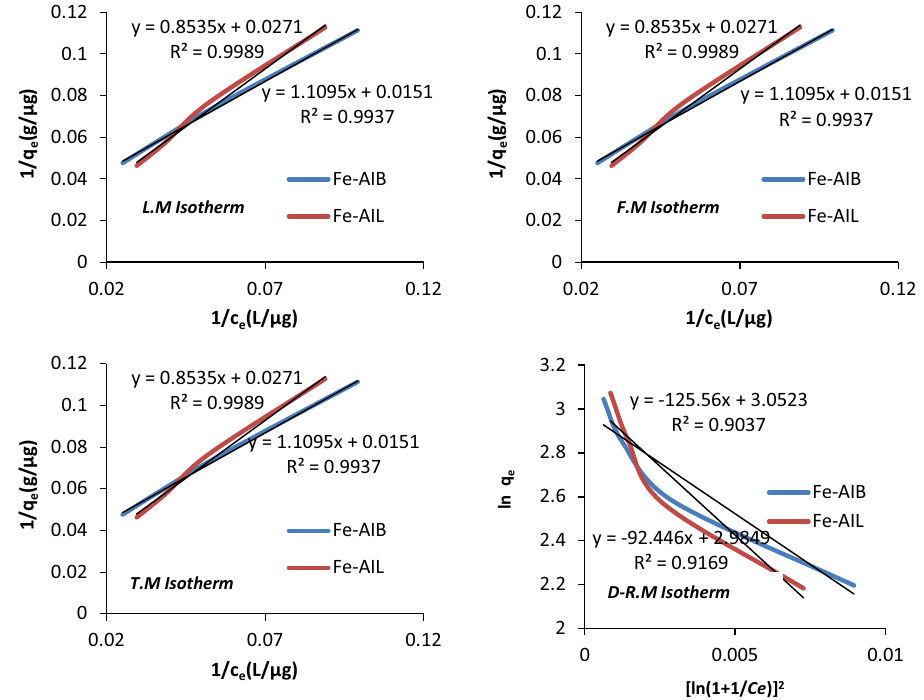
Fig. 14 Four adsorption equi- librium plots: LM isotherm, FM isotherm, TM isotherm, D–RM isotherm. (Experimental condi- tions: dose, 1 g; contact time, 60 min; pH, 6.0; temperature, 25 °C; agitation speed, 80 rpm)